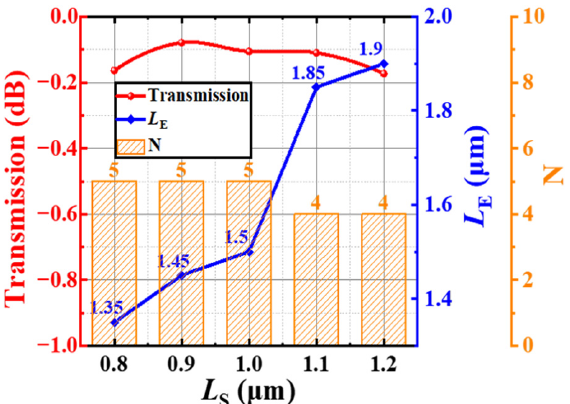
Figure 5. Device transmission of the new designed power splitter as a function of its gap length L S , where the optimal period number N and relative position L E of the embedded uniform SWG are also plotted for every gap length L S .